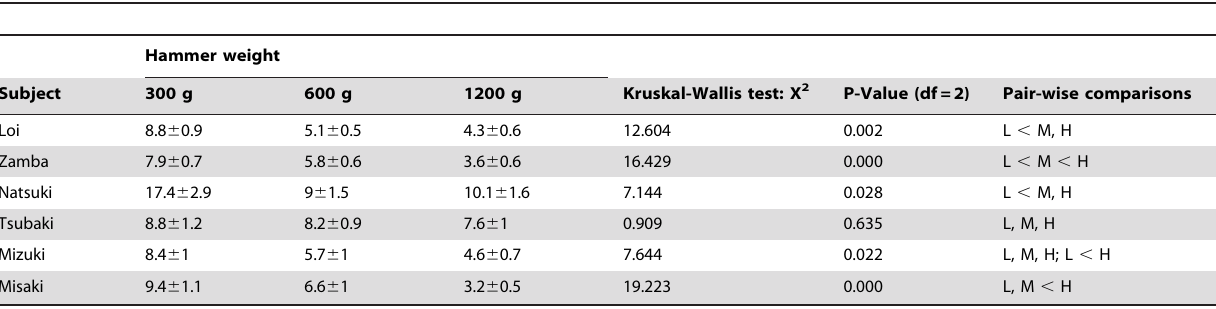
Table 4. Average number of strikes ( 6 SE) needed to solution for all subjects as a function of hammer weight in Experiment 2.